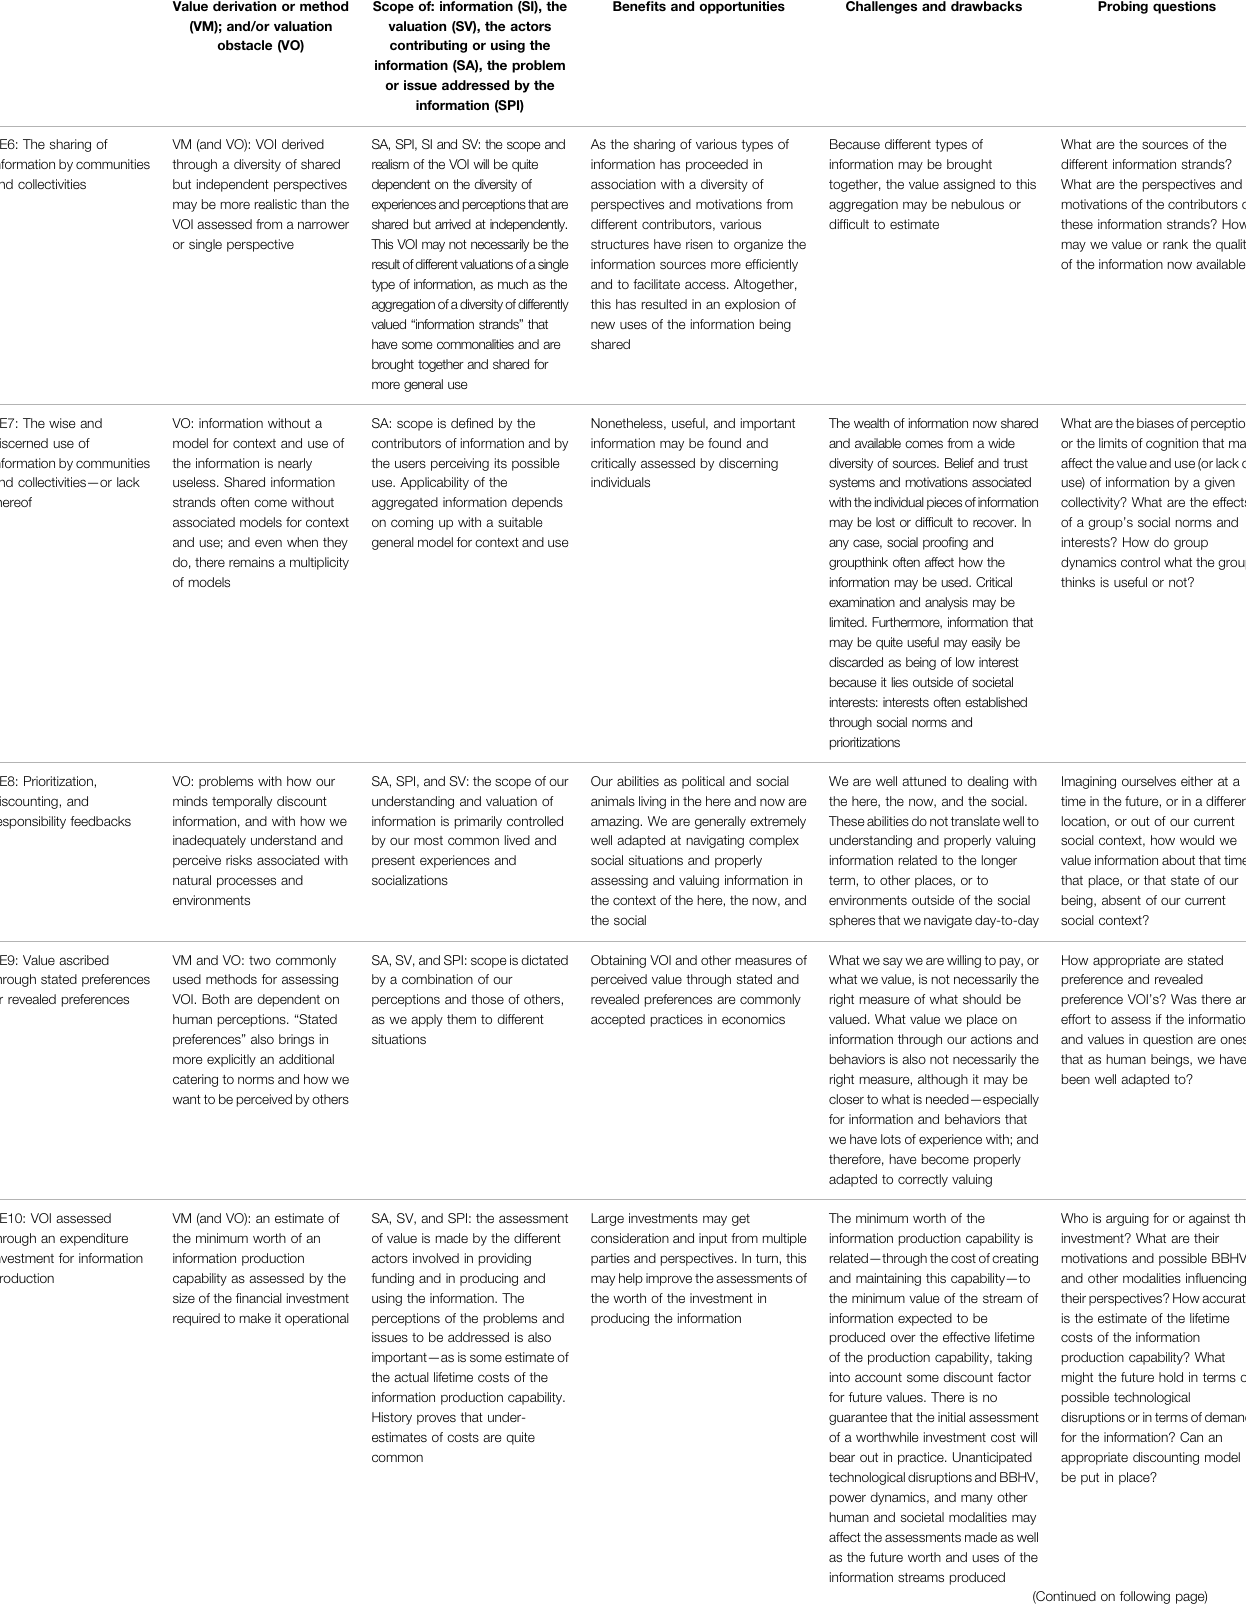
TABLE1| ( Continued )Summaryof fi fteen “ valueexplorations ” ofVOImethodologiesandofbehavioralandsocialfactorsin fl uencinginformationandVOI.Seeaccompanying article by Glynn et al. (2022, this issue) for complementary